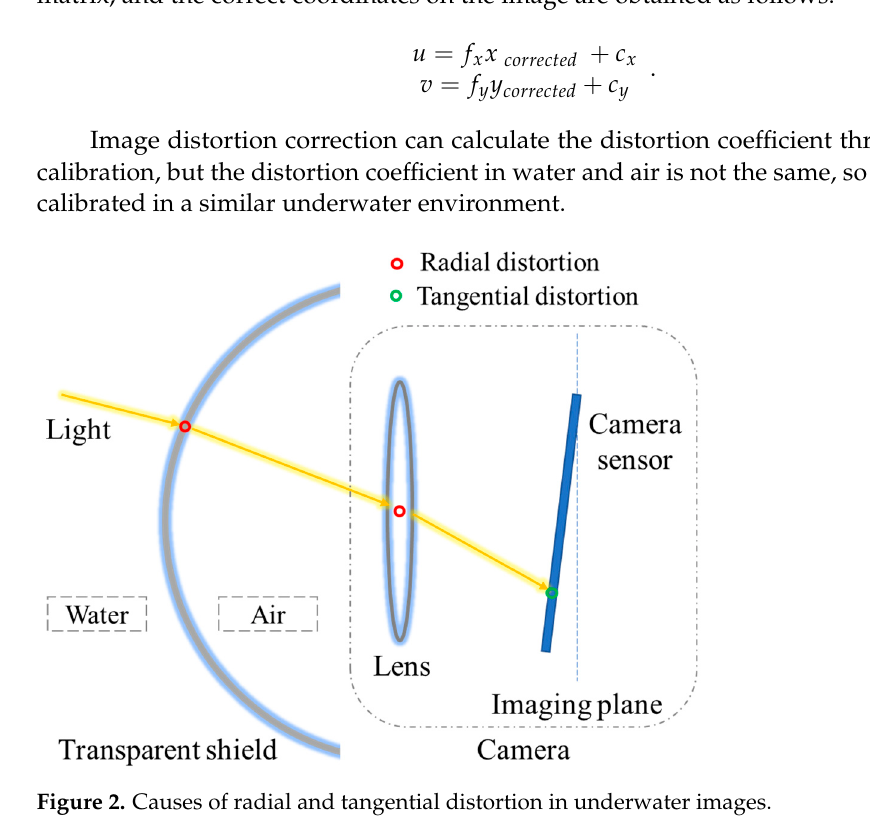
Figure 2. Causes of radial and tangential distortion in underwater images.